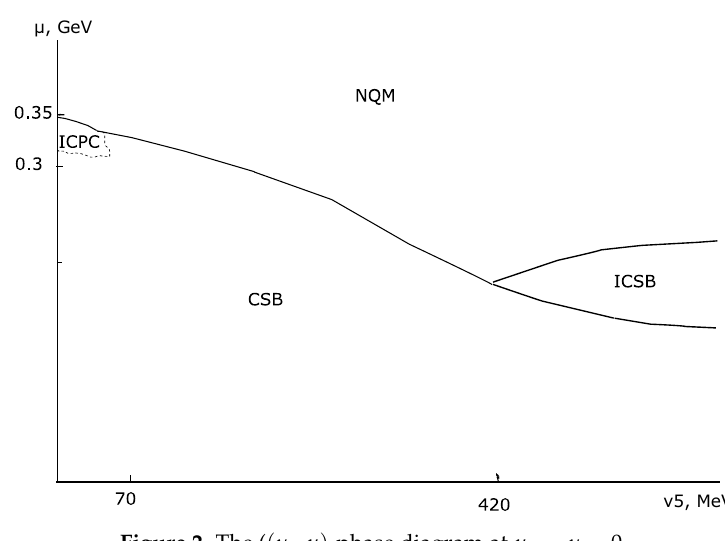
Figure 2. The ( ( ν 5 , µ ) -phase diagram at µ 5 = ν =